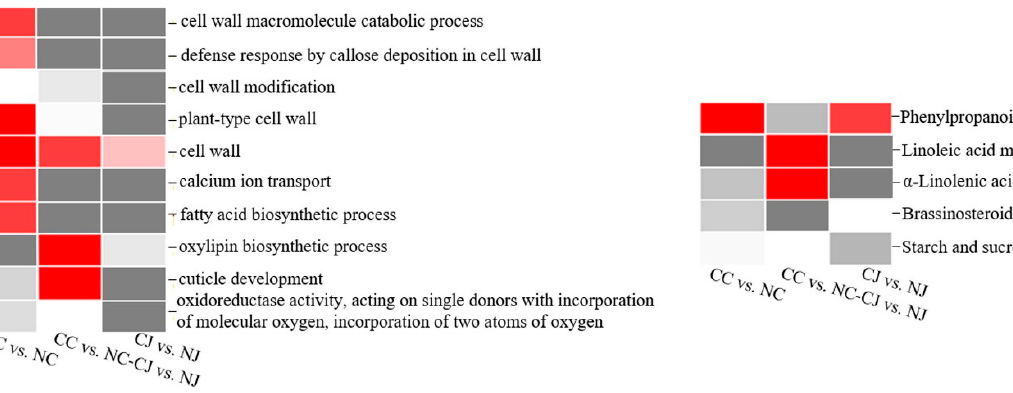
Figure 4. Results of the GO (left) and KEGG (right) enrichment analysis of the DEGs in two cracking-susceptible cultivars. The p -value was used to indicate the significance of the most represented GO and KEGG terms. Significant p -values are indicated in red, whereas nonsignificant p -values are indicated in dark gray.